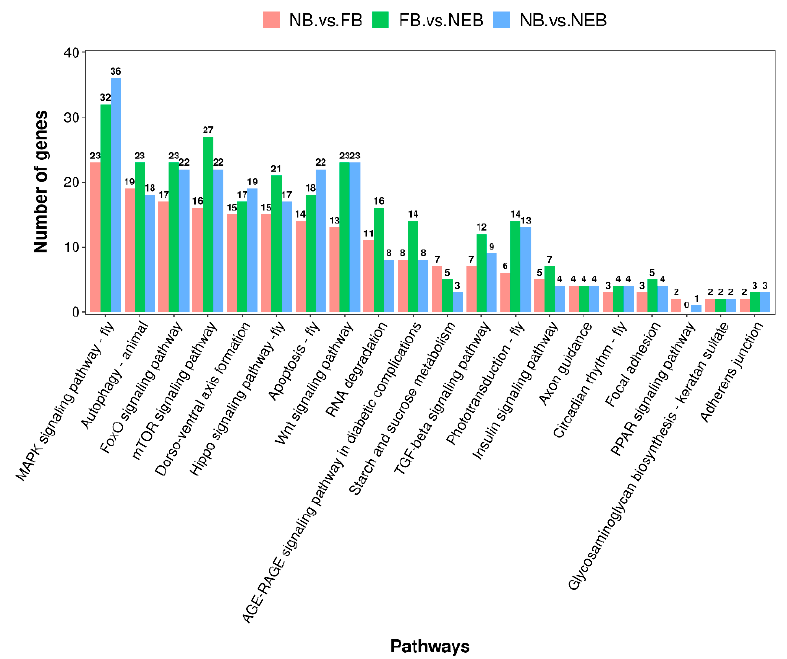
Figure 5. KEGG pathways analysis of predicted target genes of the differentially expressed miRNAs identified in the NB vs. FB comparison, NB vs. NEB comparison, and FB vs. NEB comparison. NB: nurse bee, FB: forager bee, NEB: newly-emerged bee.